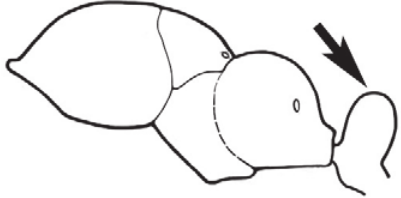
Major, media and minor worker uniformly microreticulate, in profile, petiolar node of minor and media thick and tuberculate in shape, that of major worker squamiform; tibial apical spur absent; mesosoma of minor and media workers matt, glabrous, that of major worker with ≈ 12 short, bristly, erect setae (minor and media workers orange, major worker orange with brown gaster) (NT, QLD, northern WA; arid; rare) ( JDM 970 ) (Fig. 56a–g) .................... fulvidus